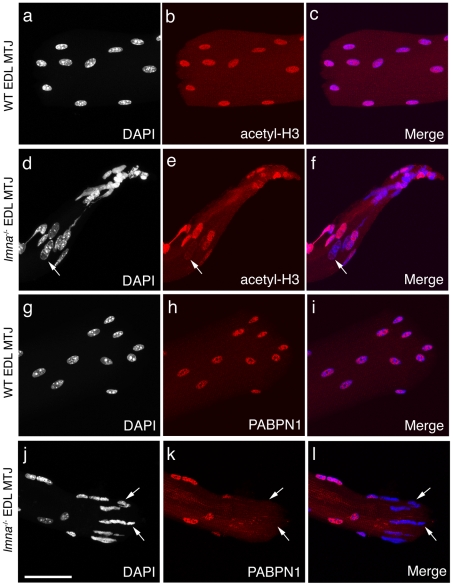
Transcriptional activity and mRNA processing are often impaired in myonuclei at the myotendinous junctions of lmna-null mice.Representative images of wild-type (WT) lmna+/+ EDL myofibres immunostained for acetyl-histone H3 (red) and counter-stained with DAPI (white), with merged images (a–c). Myonuclei at the myotendinous junction (MTJ) in WT myofibres have near homogeneous acetyl-histone H3 immunostaining, as observed along the myofibre, indicating similar levels of transcriptional activity. By contrast, immunostaining of lmna
−/− EDL myofibres revealed that myonuclei at the myotendinous junctions clearly had varying acetyl-histone H3 levels, indicating heterogeneous transcriptional activity, ranging from virtually inactive (background levels – arrow in d–f), to hyperacetylated, myonuclei (d–f). WT myonuclei also exhibit regular and homogeneous PABPN1 immunostaining at the myotendinous junction (g–i). In myonuclei at the myotendinous junctions of lmna
−/− EDL however, varying PABPN1 levels are observed, with many being virtually unstained (j–l - arrows), indicating an impairment of mRNA processing and maturation. Scale bar 50 µm.